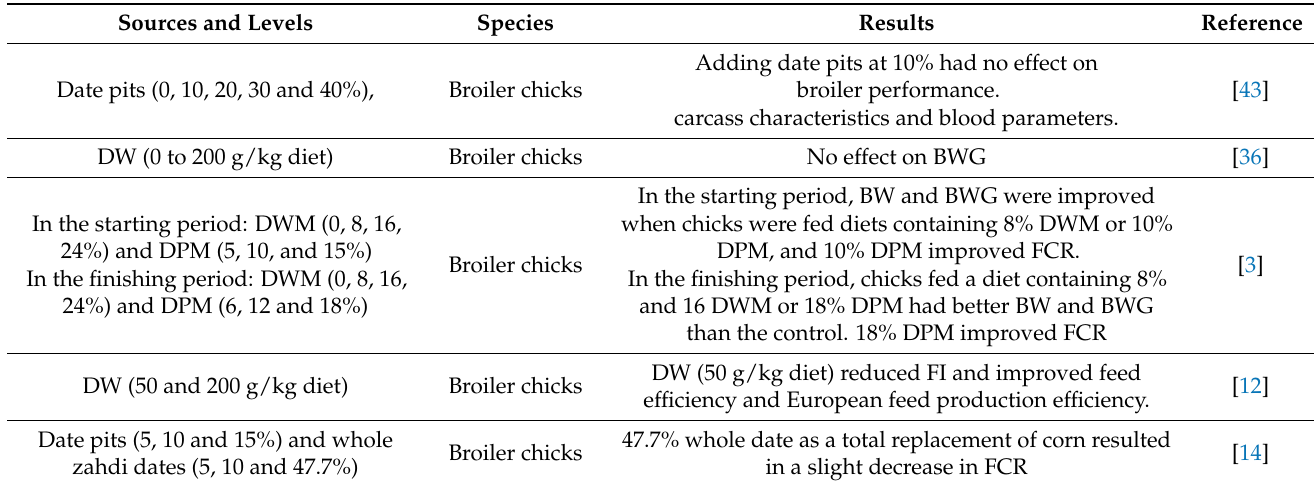
Table 7. Effects of Date by-products on performance of